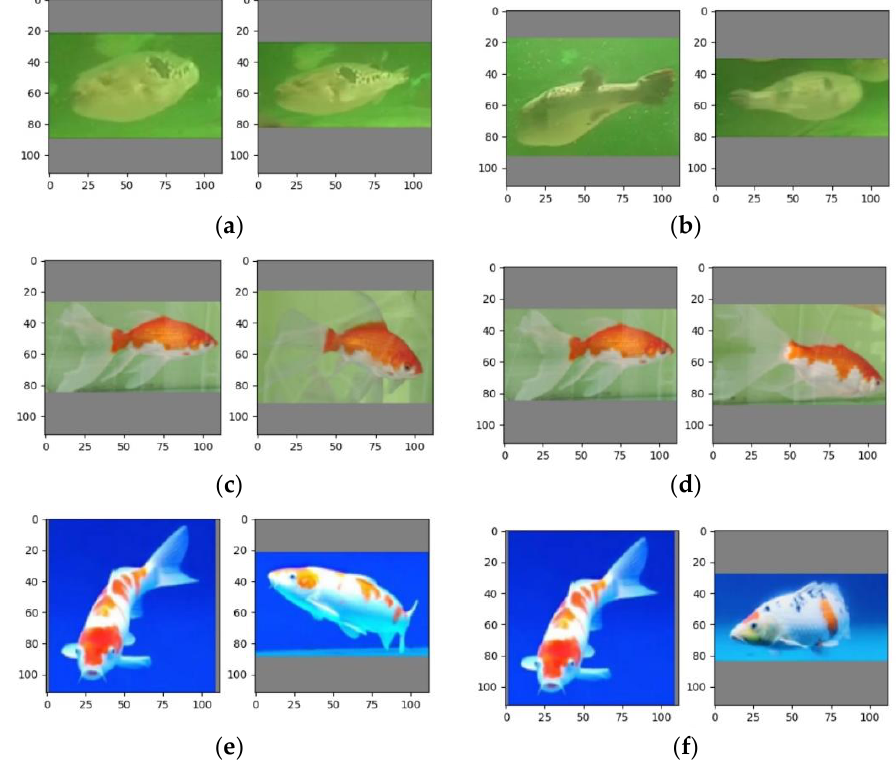
Figure 14. Recognition results of three fish species under three different conditions: ( a ) Distance: 0.265; ( b ) Distance: 1.010; ( c ) Distance: 0.271; ( d ) Distance: 1.260; ( e ) Distance: 0.623; ( f ) Distance 1.455